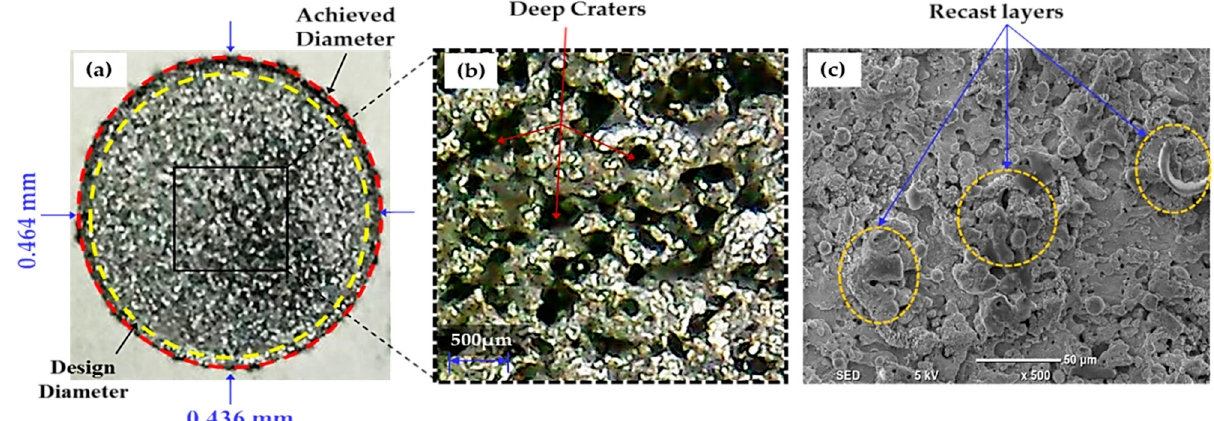
Figure 9. Experimental results for Al-electrode at positive polarity: ( a ) actual machined surface representing a high value of overcut; ( b ) deep craters are present on the workpiece surface; ( c ) SEM image shows re-cast layers formed on the specimen’s surface.